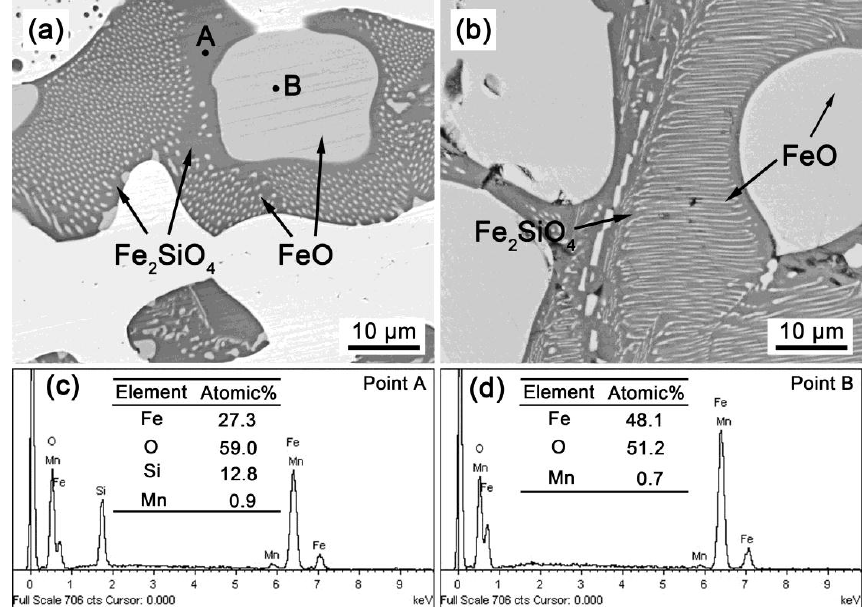
Figure 4. ( a , b ) The typical distribution of Fe 2 SiO 4 –FeO; ( c ) The energy spectra of Point A (Fe 2 SiO 4 ); ( d ) The energy spectra of Point B (FeO).